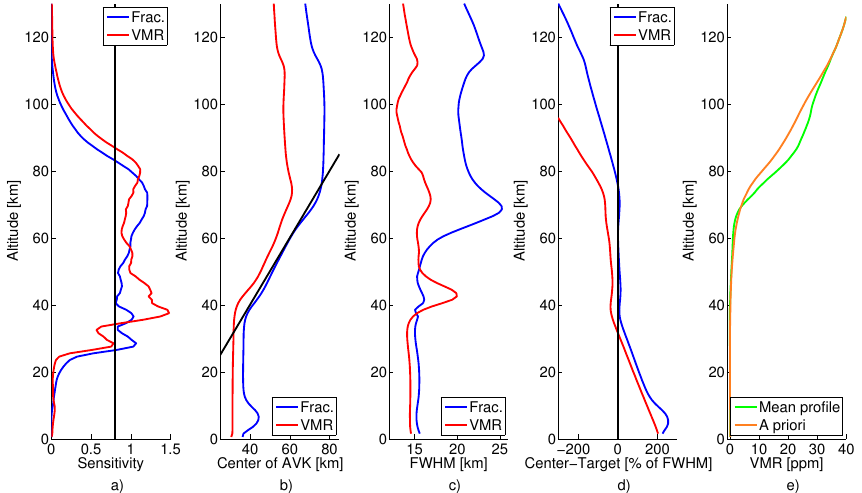
Fig. 4. Retrieval characteristics averaged over the complete dataset shown for the fractional retrieval (blue) and the retrieval converted to vmr (red). (a) Sensitivity given by the sum of the AVKs. The black solid line marks the threshold of 0.8, under which data is not considered to be reliable. (b) Altitude of the center of the AVKs. The black solid line marks the line of origin. (c) FWHM of the AVKs as a measure for the vertical resolution. Values for the vmr AVKs are not reasonable in all altitudes (Sect. 3.4.4). (d) The deviation of the curves in (b) from the line of origin normalized with the FWHM. (e) Mean profile of all retrieval results and the constant a priori.